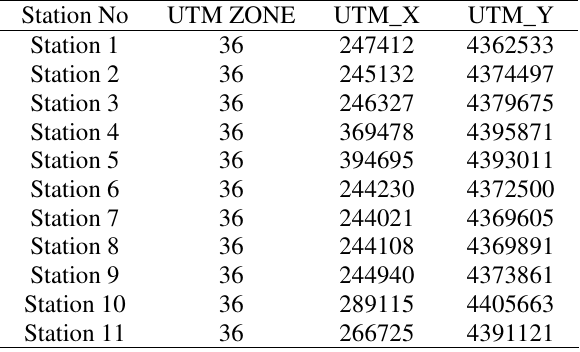
Table 1. Observation stations